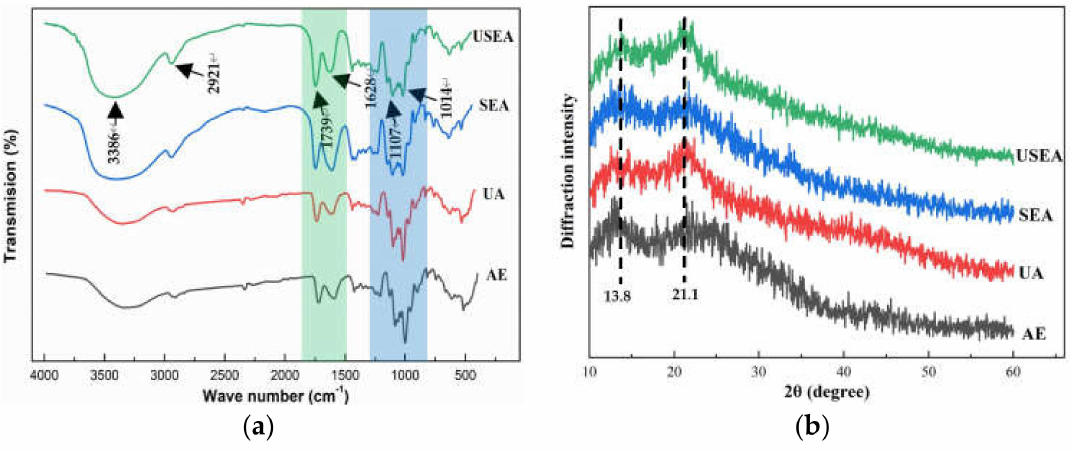
Figure 2. FT-IR spectra ( a ) and XRD patterns ( b ) of